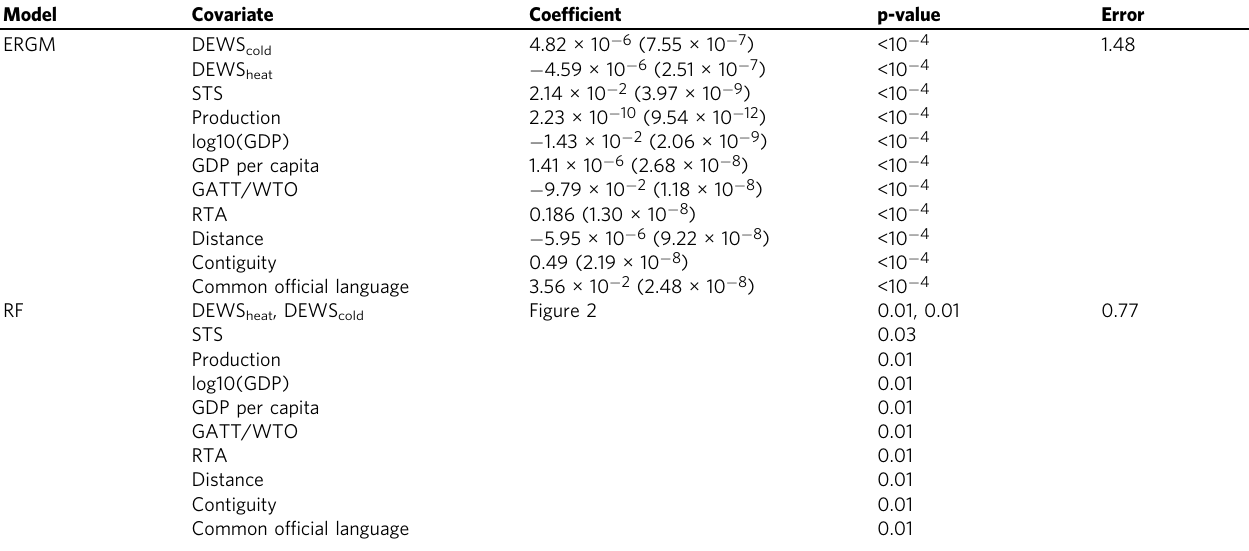
Table 2 Summaries of the models for 2005 – 2014 weighted directed (trade volume) international wheat trade network.